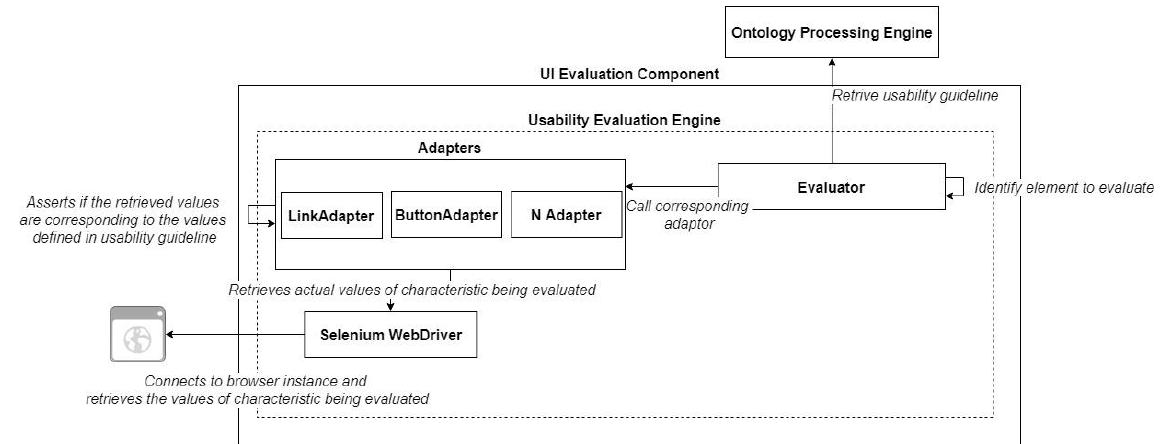
Figure 6. Process of Evaluation WUI conformance to usability